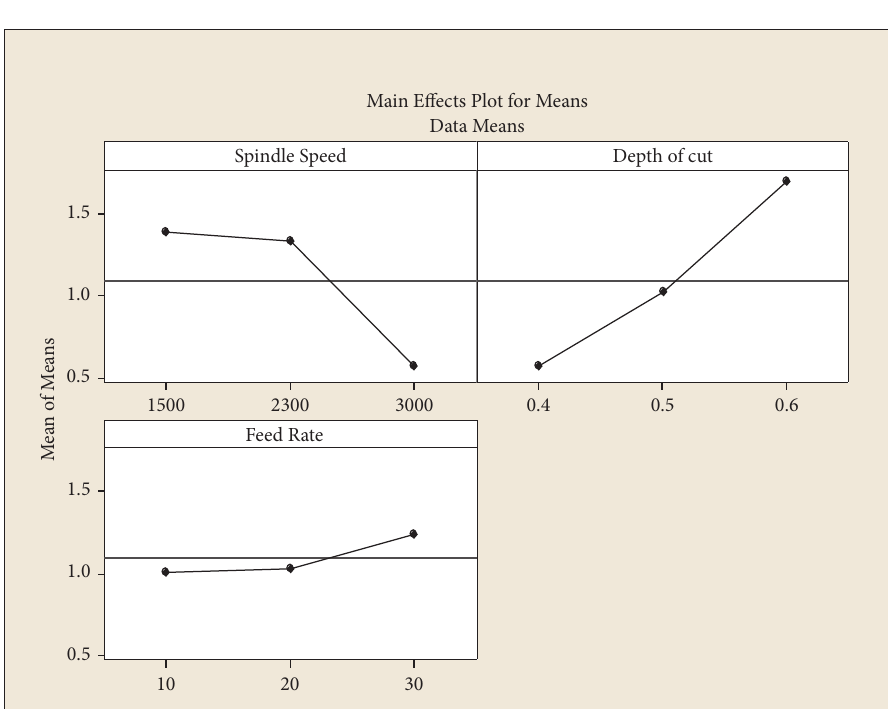
Figure 9: Means plot for